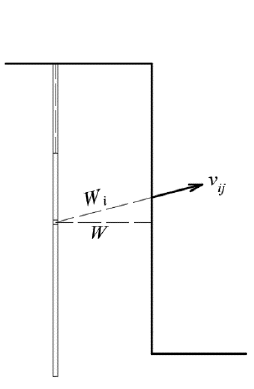
Figure 2. Velocity vector diagram.